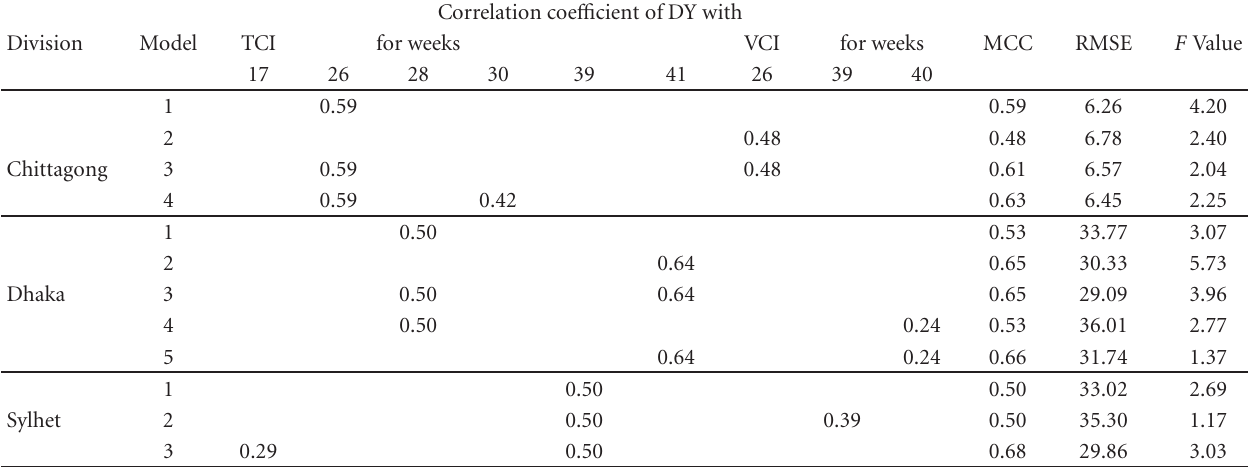
Table 1: Investigated variables, PCC, and multiple correlation coe ffi cients (MCCs) of models (DY = f (TCI, VCI)). Correlation coe ffi cient of DY with